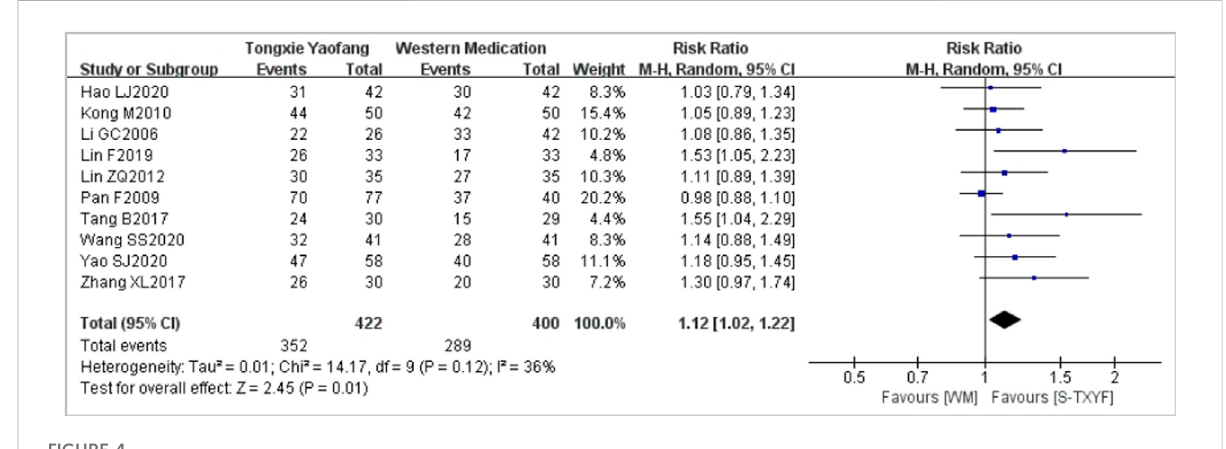
FIGURE 4 Forest plots of global improvement of IBS-D symptoms (criteria-1;